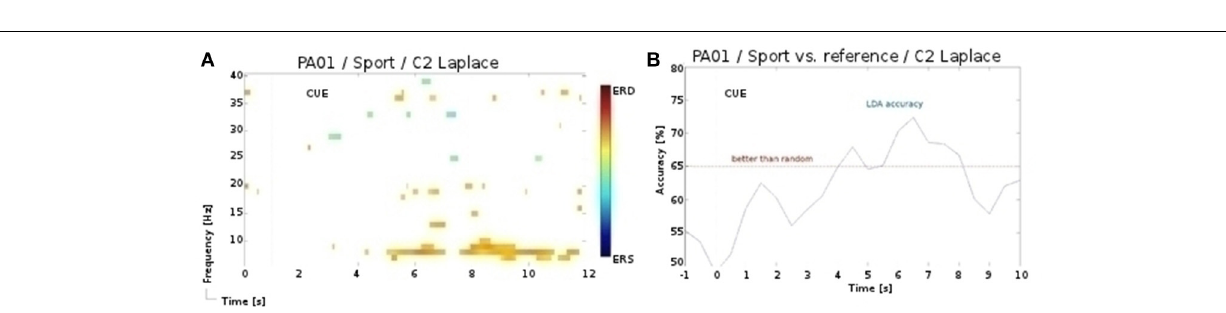
FIGURE 5 | (A) ERD/S map for the participant P1 and for the sport task of the 2nd session. (B) LDA accuracy over trial duration for this participant, sport task, and α band during the 2nd